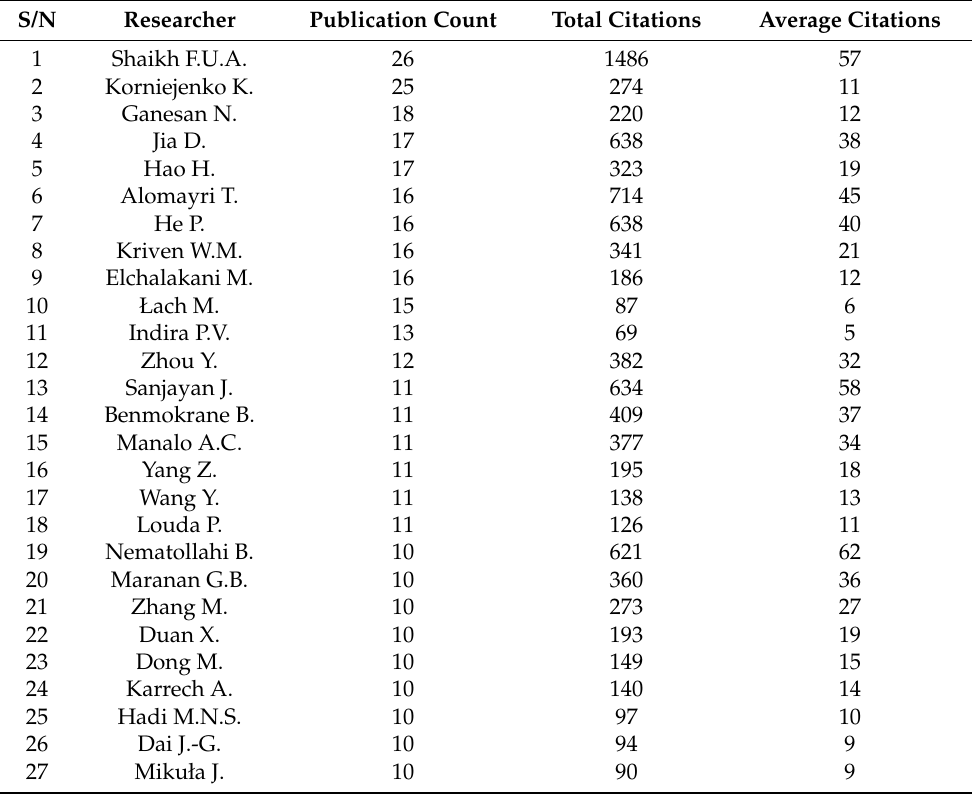
Table 3. Authors together with their publications and citations in FRGP